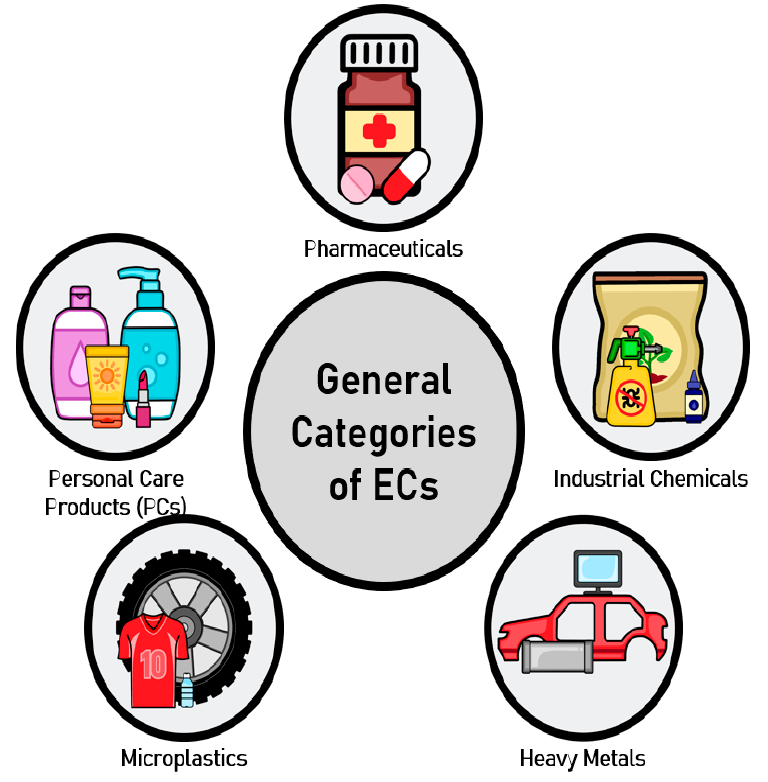
Figure 1. The sources and high concerns of ECs.